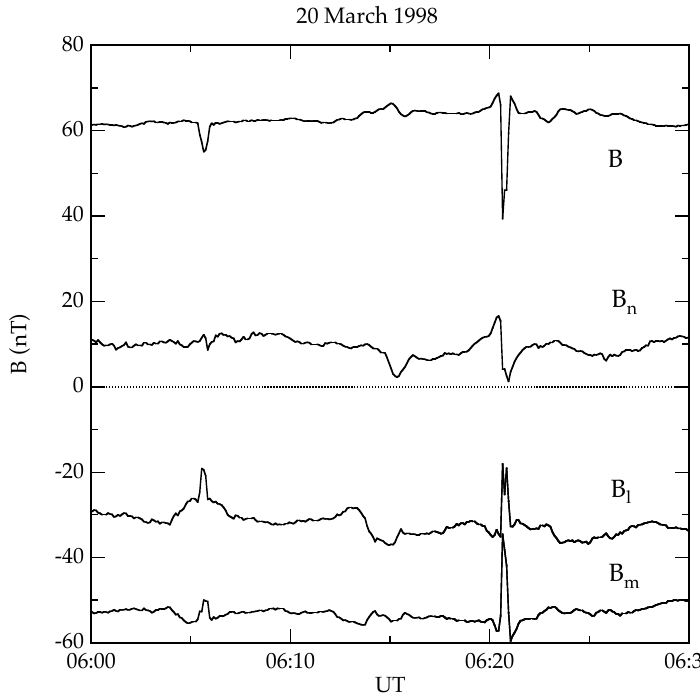
Fig. 4. Interball-1 magnetometer observations from 06:00 to 06:30 UT on 20 March 1998 in boundary normal coordinates. A crater FTE at 06:20 UT follows two less well define events at 06:06 and 0615 UT. All three events occurred within the southern